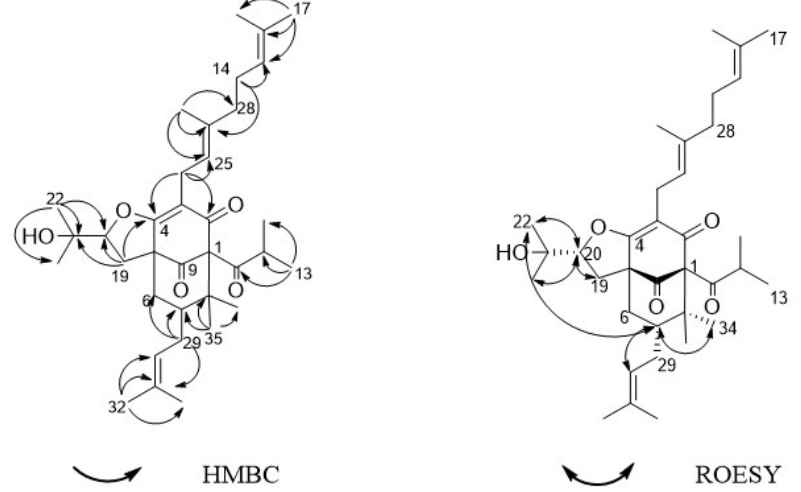
Figure 2. Selected key HMBC and ROESY correlations for 1